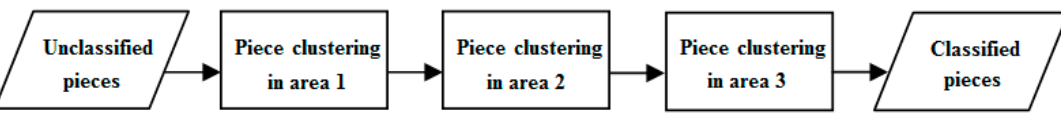
Figure 9. System flowchart of the piece clustering algorithm.